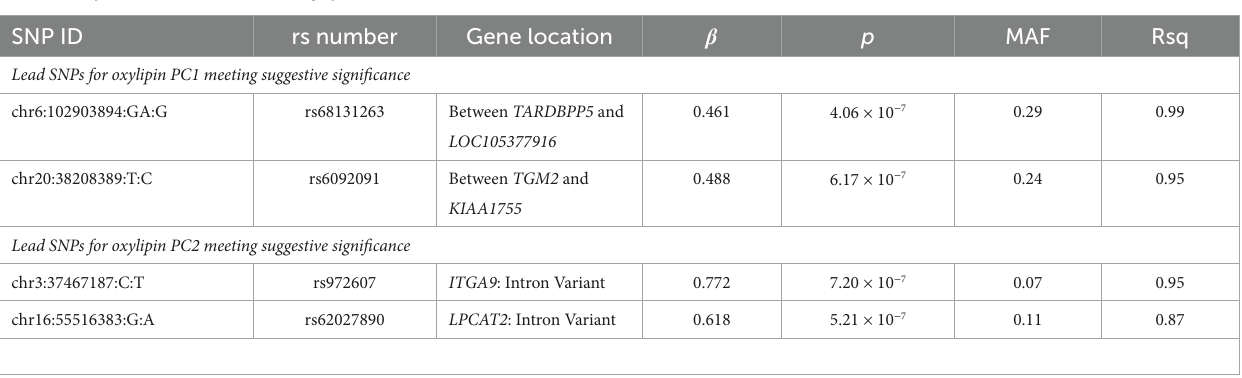
TABLE 2 Top SNPs Associated with Oxylipin PC1 and